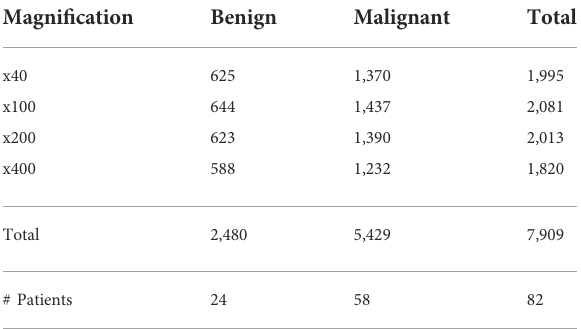
TABLE 2 Stats of the BreakHis